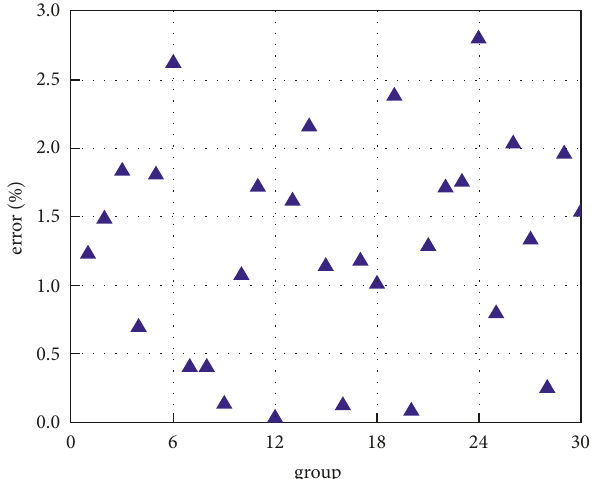
Figure 4: Prediction error of CNN and LSTM methods in pre- dicting the characteristics of music teaching effect.